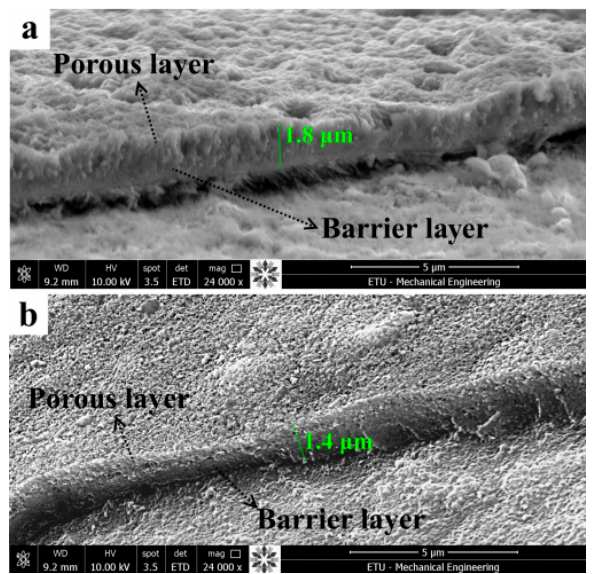
Figure 17. Cross-section SEM micrographs of ( a ) sol-gel and ( b ) SILAR samples [98]. Reprinted with permission from reference [98] 2018 Elsevier.